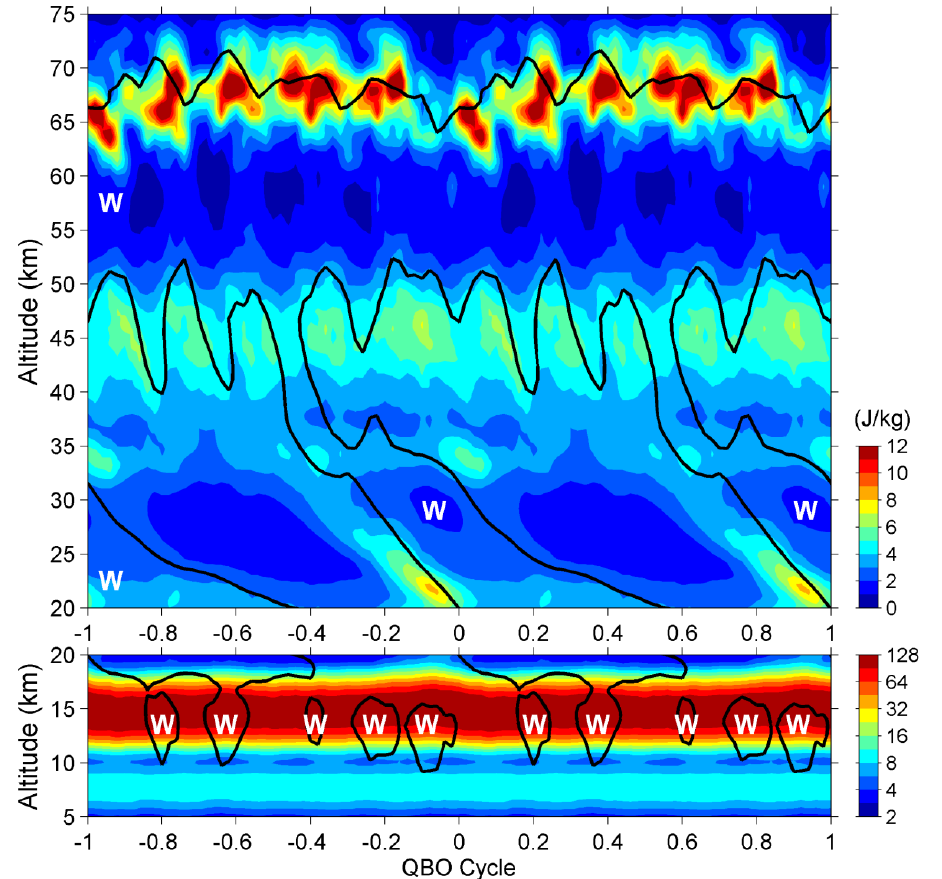
Figure 4. The time-averaged zonal mean E P at 20–75 km ( top ; in linear color scaling) and 5–20 km ( bottom ; in logarithmic color scaling) altitudes. The elapsed time is standardized to the quasi-biennial oscillation (QBO) cycle (~29.4 months), and the –1–0 QBO cycle repeats the results in the 0–1 QBO cycle for a better illustration. The black contours plot the zero-wind shears of the time-averaged zonal wind, and the westerly regimes are marked.